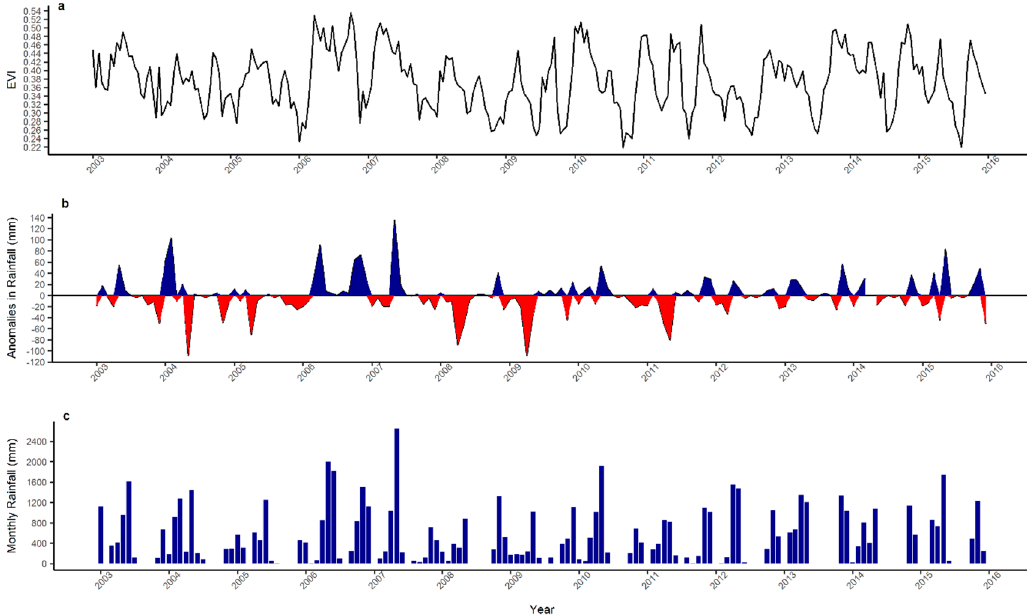
Figure 9. Temporal profiles for Shimba Hills National Reserve showing: ( a ) The EVI from MODIS spatially averaged over the study area; ( b ) Anomalies in rainfall computed from monthly TAMSAT data; ( c ) Monthly rainfall estimates from the TAMSAT data.